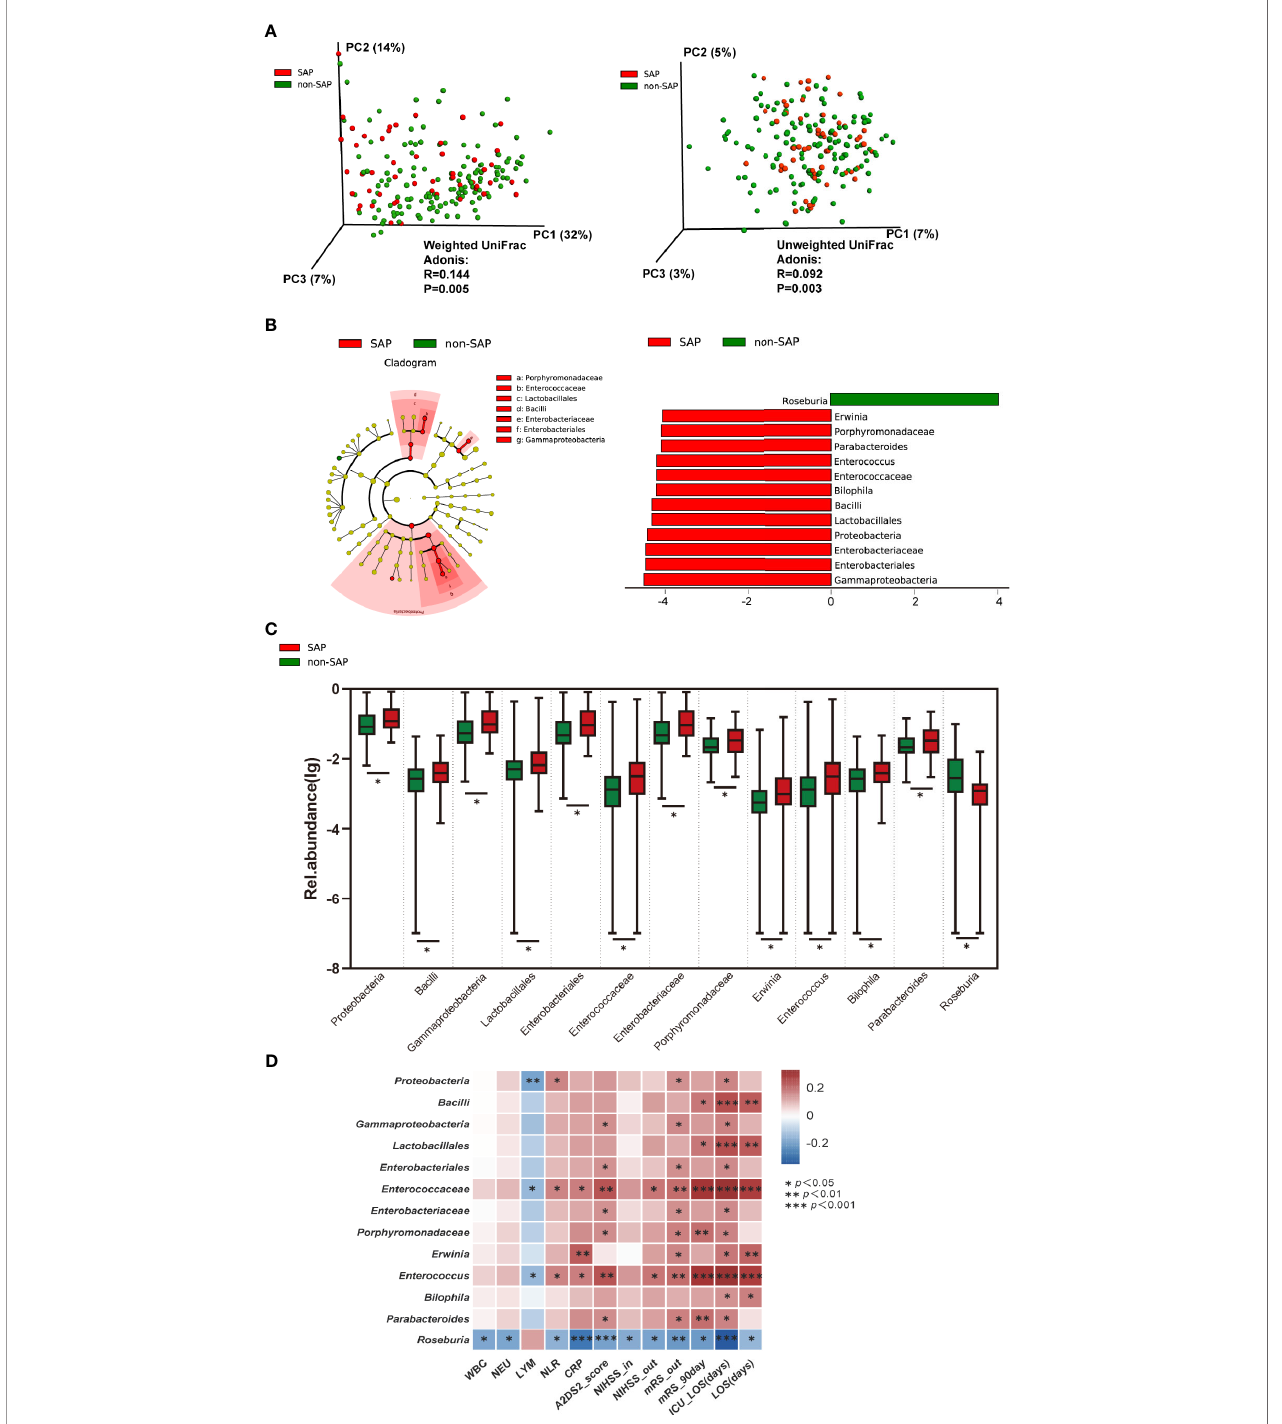
FIGURE 2 | Comparison of the microbial communities of the SAP and non-SAP groups in the training cohort. (A) PCoA plot with Weighted and Unweighted UniFrac distance analyses demonstrating that the bacterial communities were signi fi cantly different between the SAP (n = 52) and non-SAP group (n = 136). (B) LEfSe identi fi ed the 13 most differentially abundant taxa with relative abundance higher than 0.1% between the two groups in the training cohort. (C) Relative abundance of the 13 taxa differed in two patient groups. (D) Heat map of Spearman ’ s rank correlation coef fi cient among clinical indexes and 13 taxa. NIHSS-in, initial NIHSS